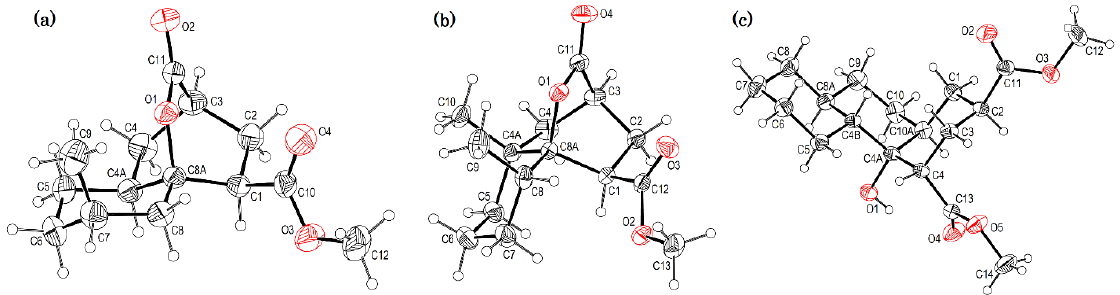
Figure 2. ORTEP projections of (from left to right): ( a ) trans -decalin derivative 2c ; ( b ) cis -decalin derivative 2d , and ( c ) perhydrophenanthrene derivative 2j . Displacement ellipsoids for the non- hydrogen atoms are drawn at 30% probability.